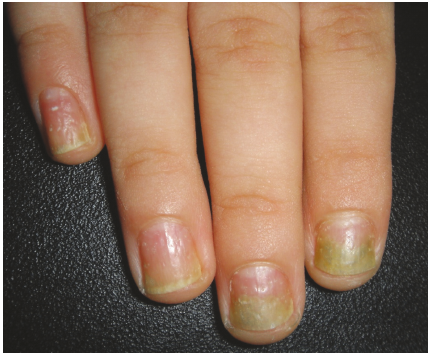
Figure 1: Pitting and onycholysis in a psoriatic patient.